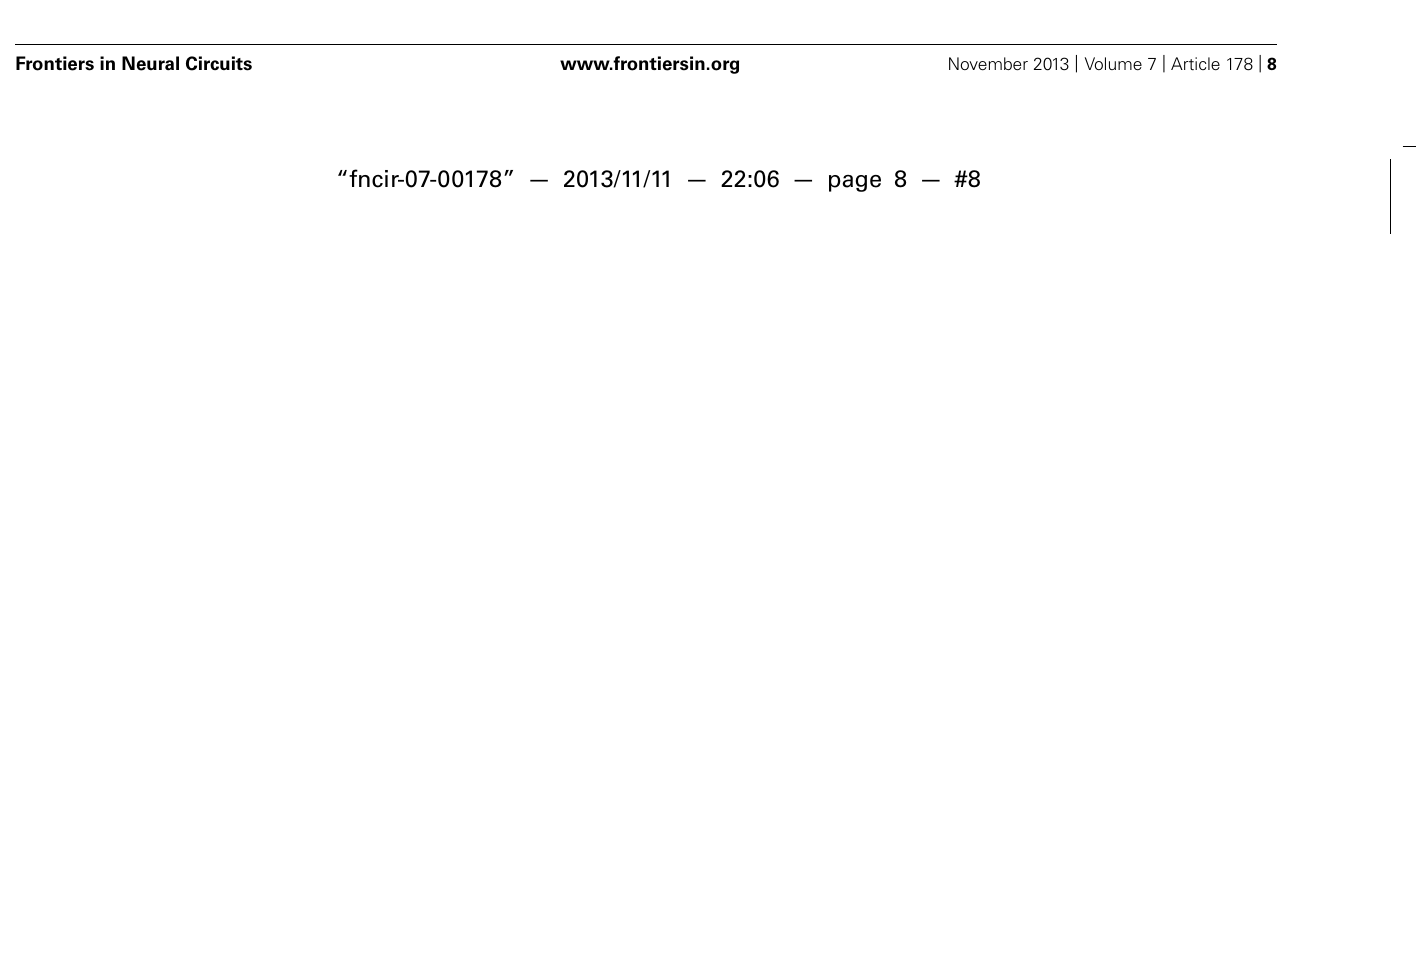
gray horizontal line marks k = 1, which corresponds to the special case where the stretched exponential “collapses” and becomes equal to the standard exponential distribution. No statistically significant differences between the age groups are present in either humans or zebrafish. (C,G) Wake bout distribution of pooled values for each group, with overlain power-law fits in darker shades, shown on a log–log scale. (D,H) Open circles indicate the value of the power-law exponent α from the fits to the pooled distributions, while filled squares show the mean of the α ’s from the individual fits and the error bars show the standard error. For humans, no significant change is seen on the α across age. In zebrafish, the larval stages (blue, green) have statistically significantly larger power-law exponents than the adult fish (orange,